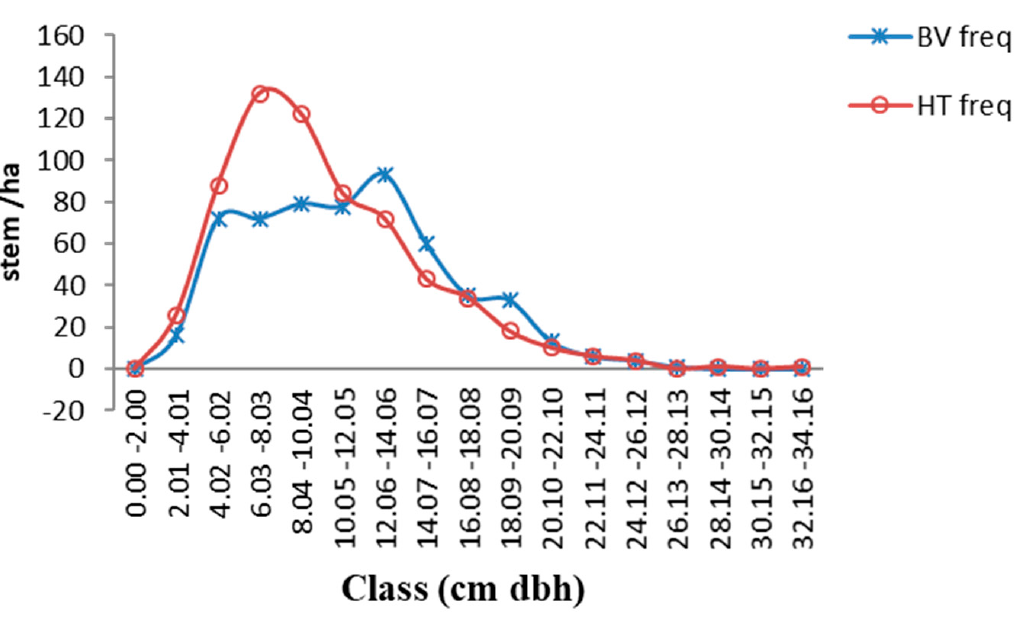
Figure 2. Diameter distribution of the Teak stand in the Valley-Bottom and Hilltop stands in the Omo Forest reserve. Table 1. Statistics of the diameter distributions of the Tectona grandis stand in the Valley-Bottom and Hilltop habitats of the Omo Forest